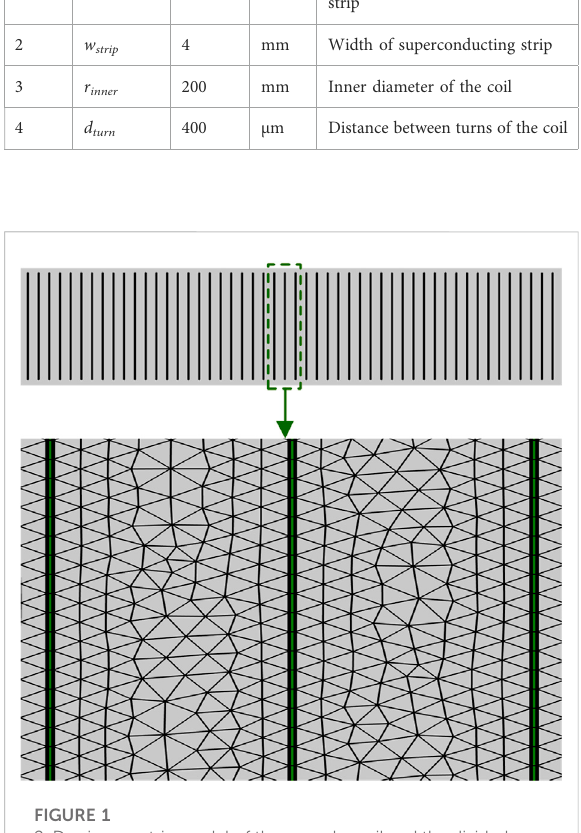
FIGURE 1 2-D axisymmetric model of the pancake coil and the divided mesh (locally